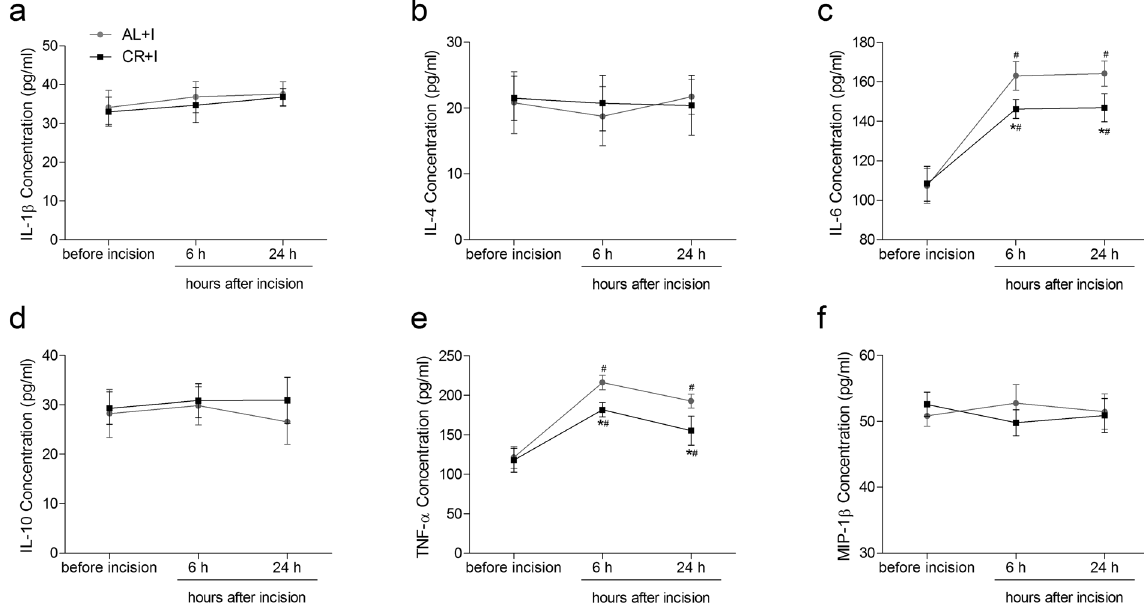
Figure 4. Effects of caloric restriction on pro-inflammatory and anti-inflammatory cytokines in serum after incision. Levels of IL-1 β ( a ), IL-4 ( b ), IL-6 ( c ), IL-10 ( d ), TNF- α ( e ) and MIP-1 β ( f ) in serum (pg/mL) measured before, 6 h, and 24 h after incisional surgery (n = 5). Values expressed as mean ± SD. The treatment style was same as described in Fig. 1. Significant difference was revealed after two-way ANOVA ( * P < 0.05 in